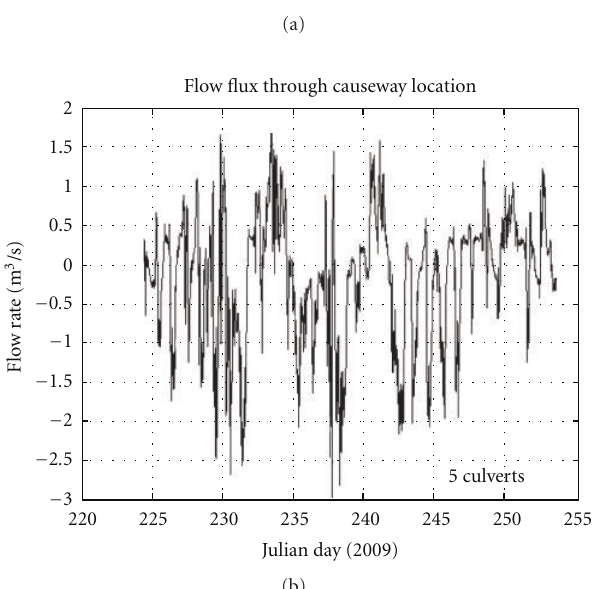
Figure 21: The model mesh used in the simulation for the causeway with a 5 culvert configuration.